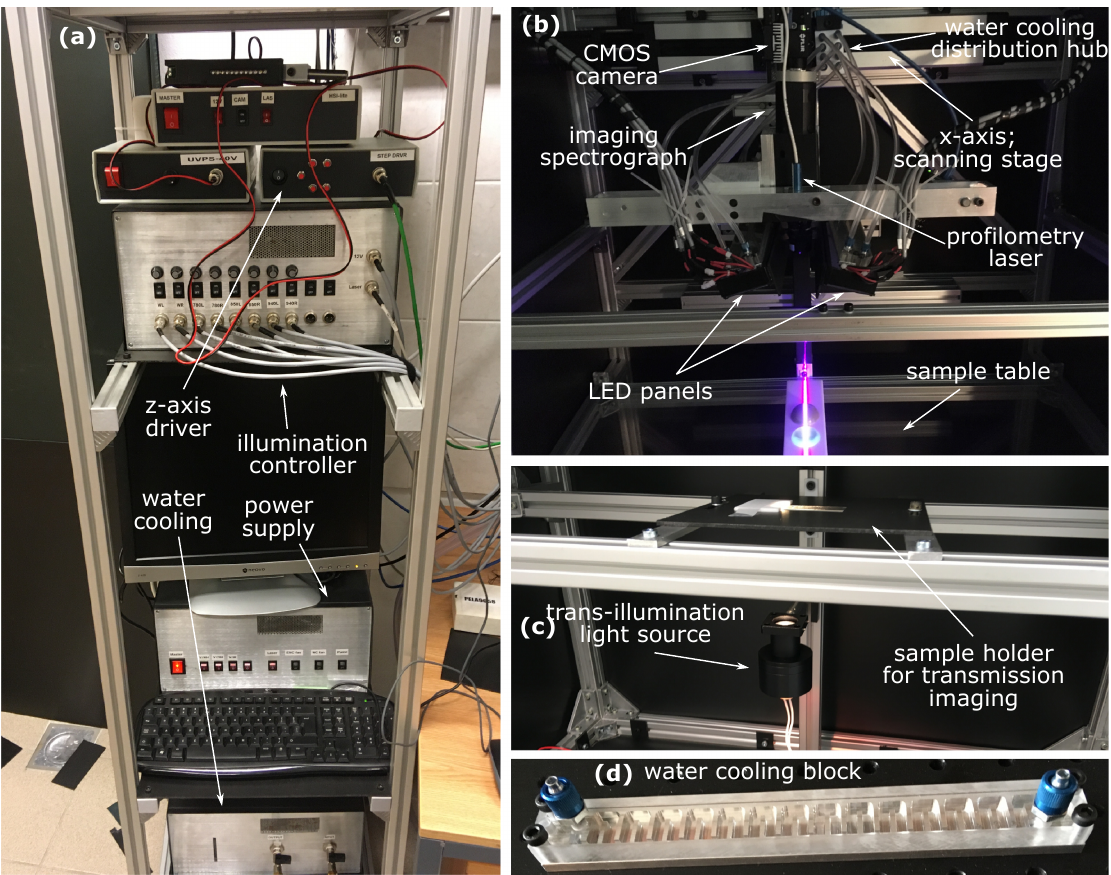
Figure 1. The custom-made laboratory hyperspectral imaging (HSI) system with annotated com- ponents: ( a ) drivers, power supply and water cooling; ( b ) reflectance imaging system illuminating two phantoms with a profilometry laser; ( c ) setup for transmittance imaging; ( d ) a single LED, water-cooled, broadband LED illumination module from the cooling block side